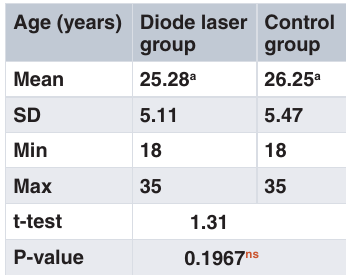
Table 1. Age of participants.